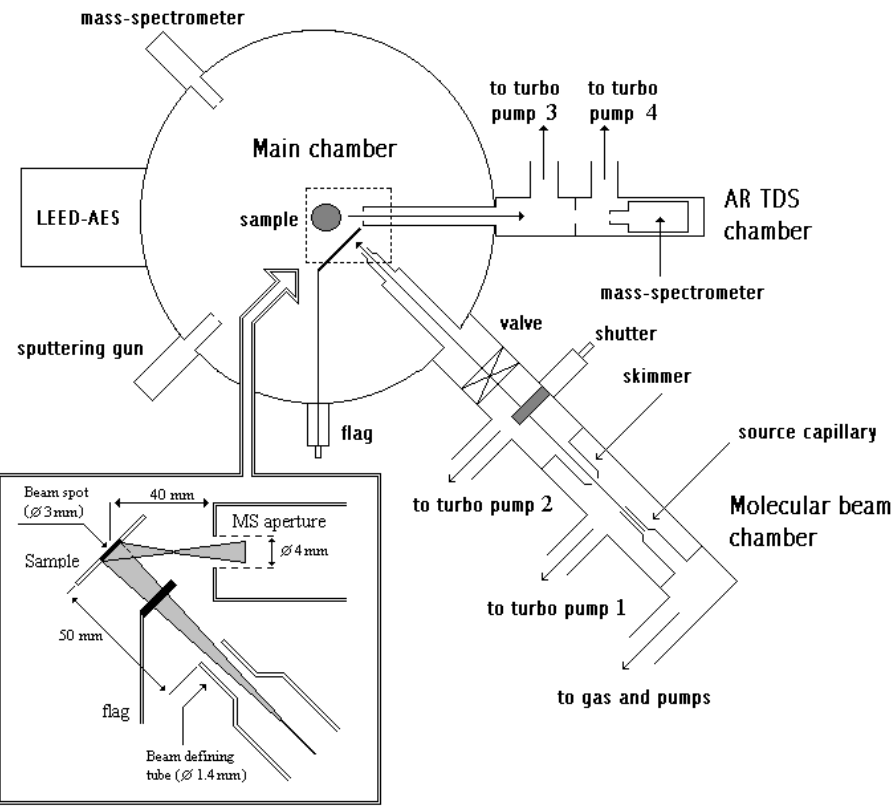
Figure 14. Schematic diagram of the molecular beam apparatus. The small insert illustrates the angle-resolved experimental facility.